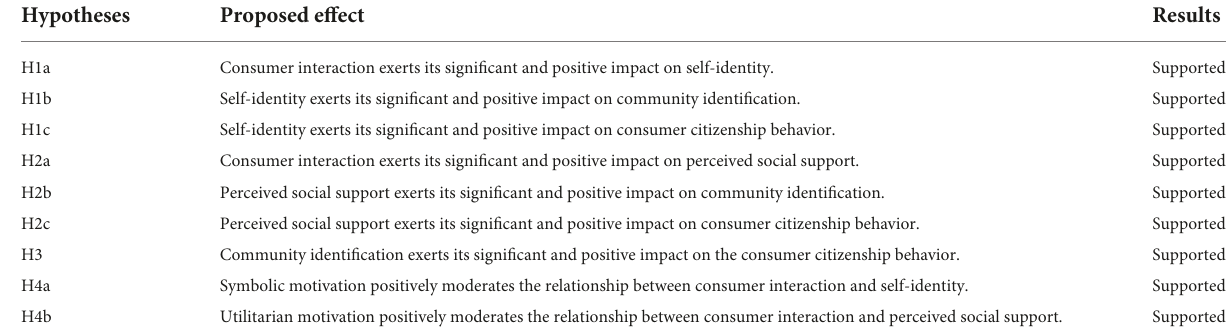
TABLE 6 Summary of hypothesis testing